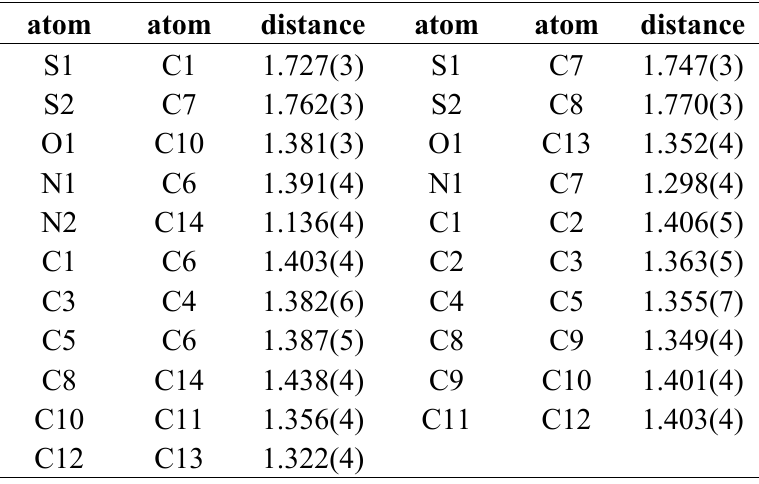
Table 4. Bond lengths (Å) for compound 4a .